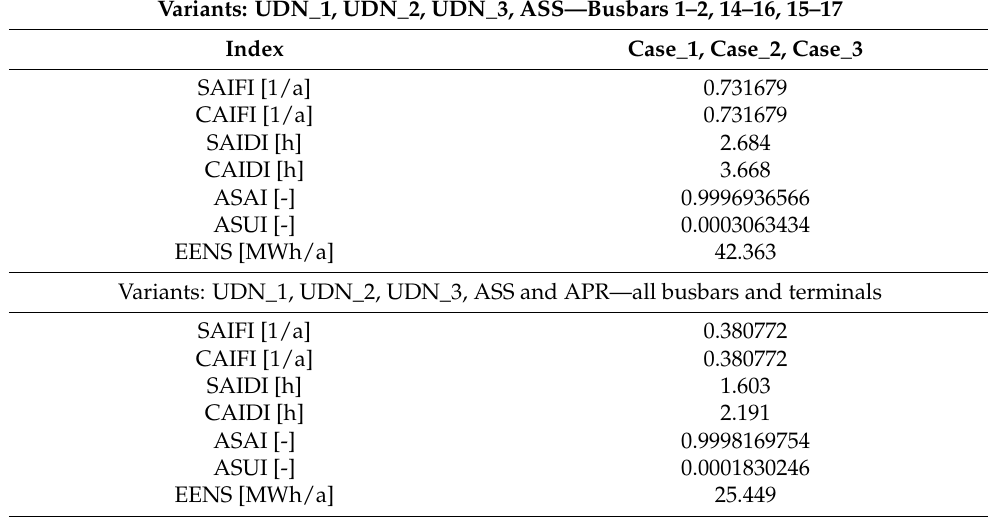
Table 9. Reliability system indices for UDN structure (Figure A1).